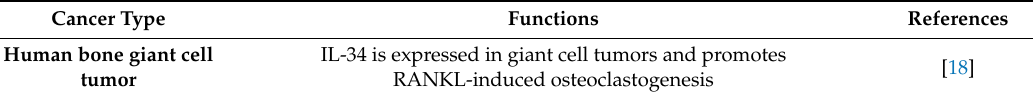
Table 1. IL-34 expression in di ff erent cancer